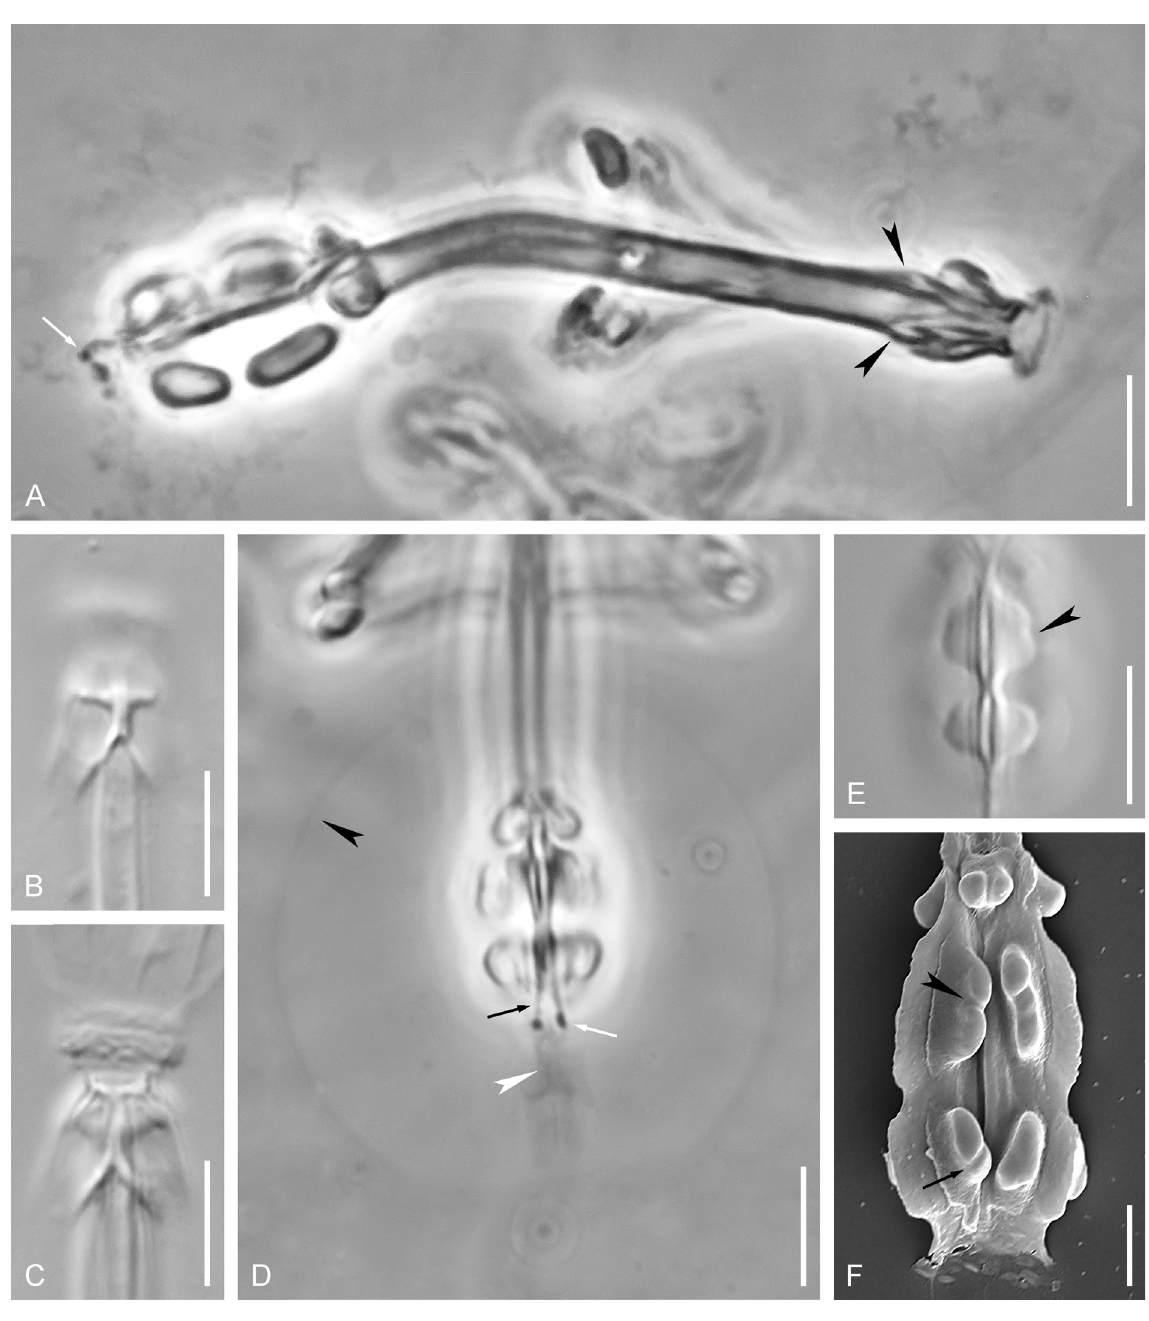
Fig. 5. Hypsibius pallidoides Pilato, Kiosya, Lisi, Inshina & Biserov, 2011, bucco-pharyngeal apparatus. A . Lateral view of the bucco-pharyngeal apparatus, black arrowheads indicate the thickenings of the buccal tube, white arrow indicates the septulum (SPbu 251(109)), PhC. B . Dorsal AISm (SPbu 251(82)), DIC. C . Ventral AISm (SPbu 251(82)), DIC. D . Pharyngeal bulb, black arrowhead indicates the pharynx outline, black arrow indicates the cuticular line connecting second macroplacoid with septulum, white arrow indicates the septulum, white arrowhead indicates the “pseudoseptulum” (SPbu 251(89)), PhC. E . Macroplacoids, black arrowhead indicates the constriction of the first macroplacoid (SPbu 251(89)), DIC. F . Cuticular structures of the pharynx, black arrowhead indicates the constriction of the first macroplacoid, black arrow indicates the constriction of the second macroplacoid, SEM. Scale bars: A–E = 5 µm; F = 2